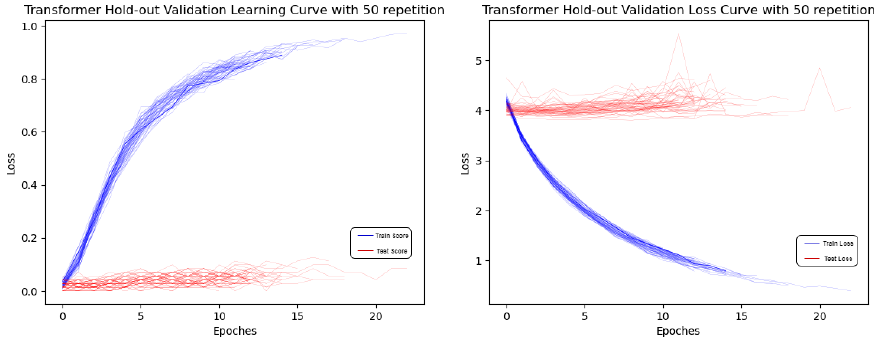
Figure 16. Transformer over-fitting phenomena on smartwatch dataset in 50